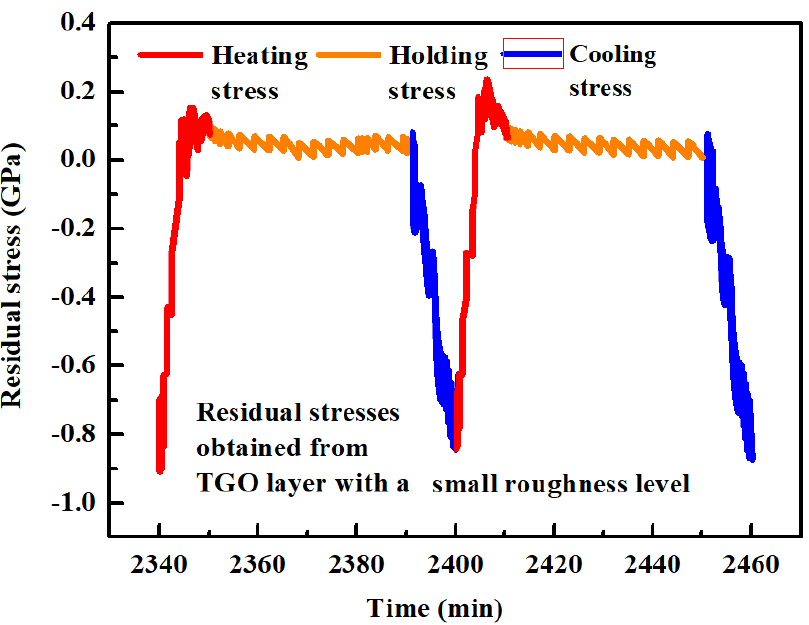
Figure 40. The out-of-plane cyclic residual stress within the TGO layer using a model with small roughness imperfections under cyclic thermal conditions.